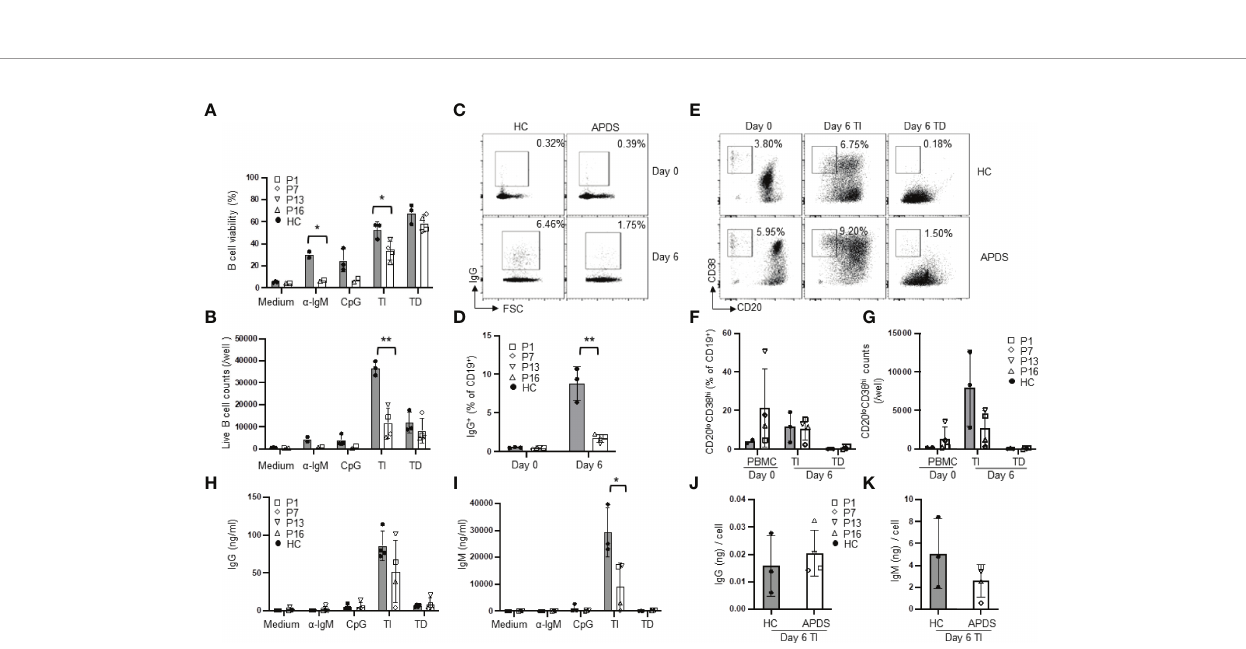
FIGURE 4 | Reduced CSR but relatively normal plasma cell differentiation in patients ’ B cells. Puri fi ed naïve B cells were cultured for 6 days in medium alone or in the presence of the indicated stimuli and analyzed for B cell survival, Ig gene CSR, plasma cell differentiation and antibody secretion. (A) B cell viability. (B) Live B cell numbers. (C, D) The proportions of IgG + B cells in freshly isolated naïve B (day 0) and naïve B cells cultured for 6 days with CD40L + IL-4. Representative FACS pro fi les (C) and results of 3 HC and 4 patients (D) are shown. (E – G) In vitro PB differentiation. (E) Representative FACS pro fi les of CD19 + cells in PBMC (day 0) and in naïve B cells cultured for 6 days with TI or TD stimuli. (F) Proportion and (G) number of plasmablasts in HC and the patients. (H and I) Naïve B cells were cultured under the indicated conditions for 6 days and the levels of IgG (H) and IgM (I) in the culture supernatants were measured by ELISA. (J, K) IgG (J) and IgM (K) secretion on a per PB basis. The amount of IgG (H) or IgM (I) in the culture supernatants of TI stimuli was divided by the total number of PB shown in (G) . HC, n=2-3; Patient, n=2-4. * p < 0.05; ** p < 0.01 (unpaired